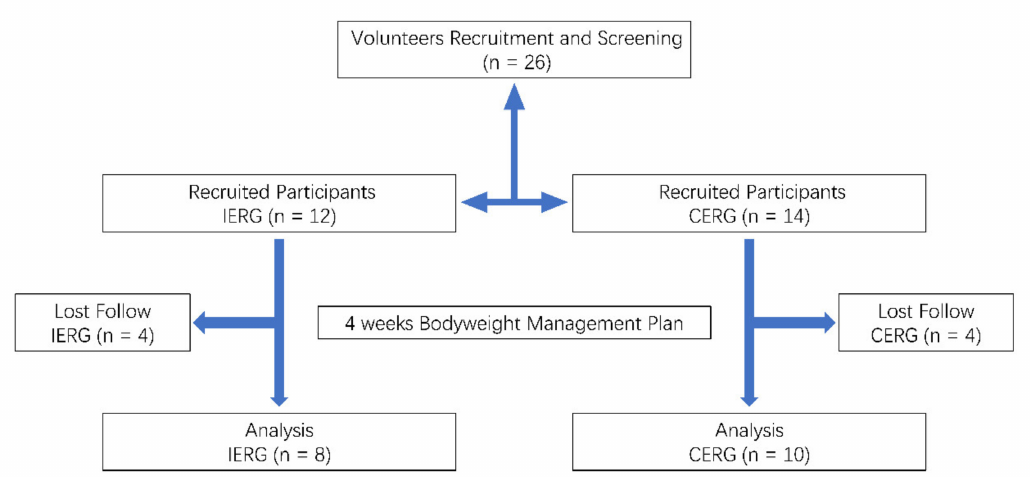
Figure 2. The flow diagram of the whole